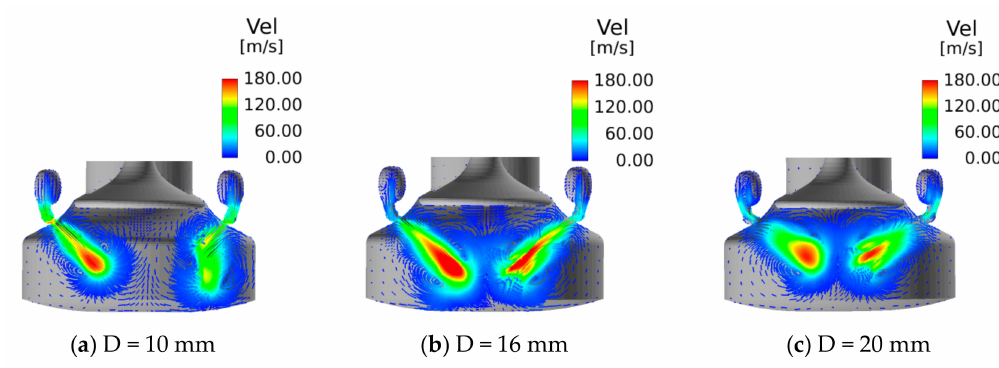
Figure 10. Flame velocity vector